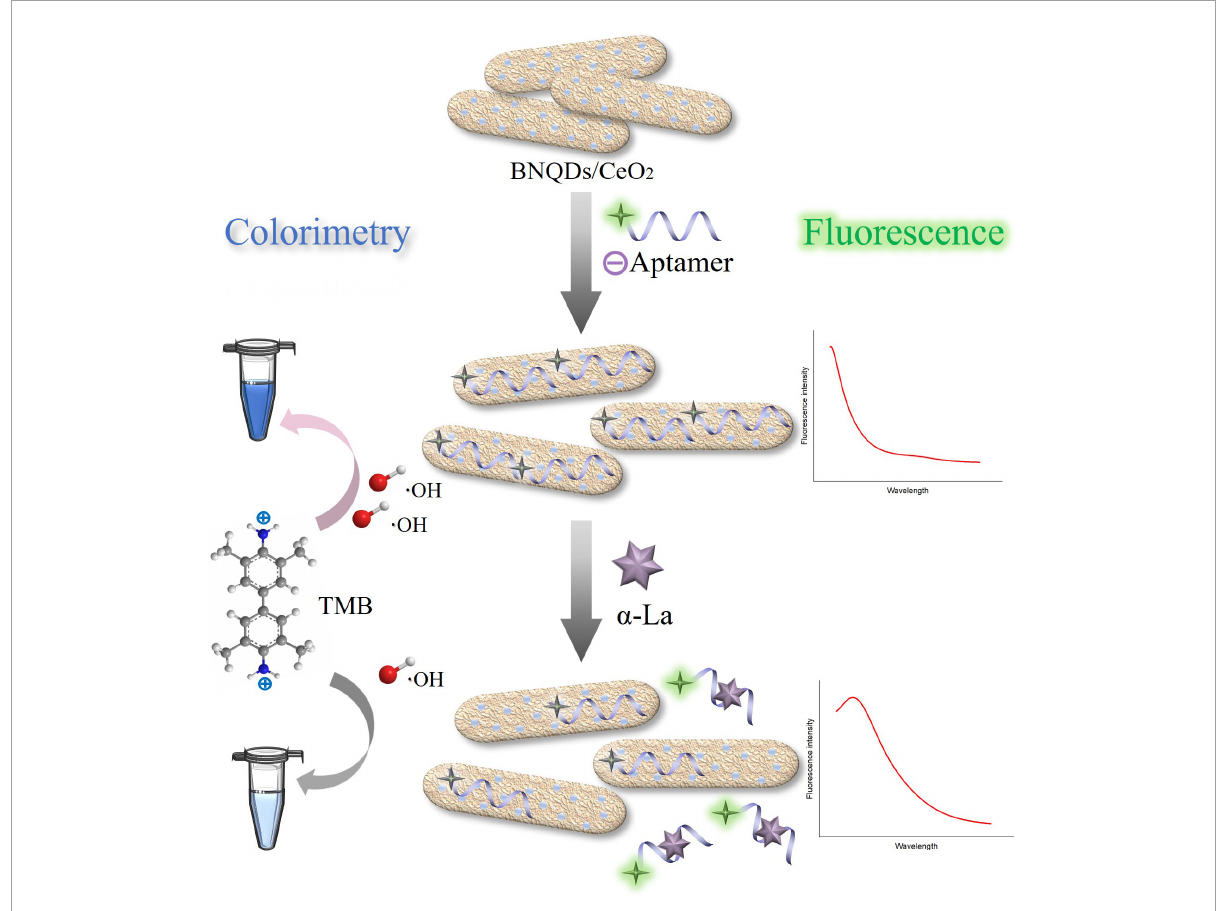
FIGURE3 Mechanism of dual-sensing strategy for α -lactalbumin ( α -La)